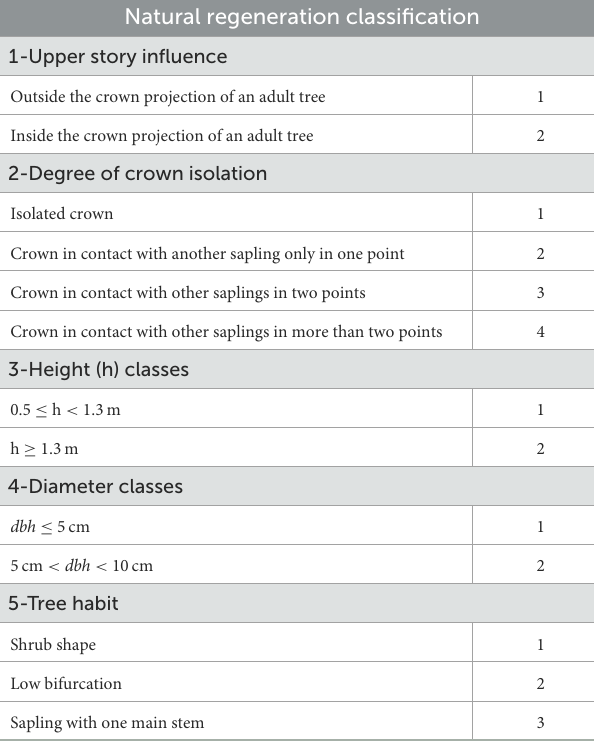
TABLE 1 Natural regeneration classification created for evaluating the quality of the regeneration present in each plot. Natural regeneration classification